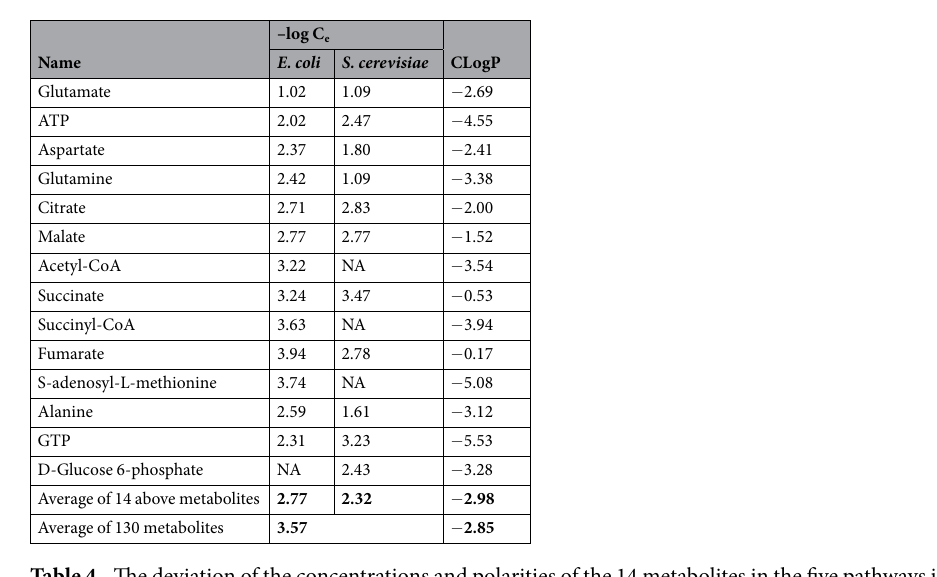
Table 4. The deviation of the concentrations and polarities of the 14 metabolites in the five pathways included in the MPF descriptor. − log C e is the negative logarithm of the corresponding concentration in E. coli and S. cerevisiae . NA means no data